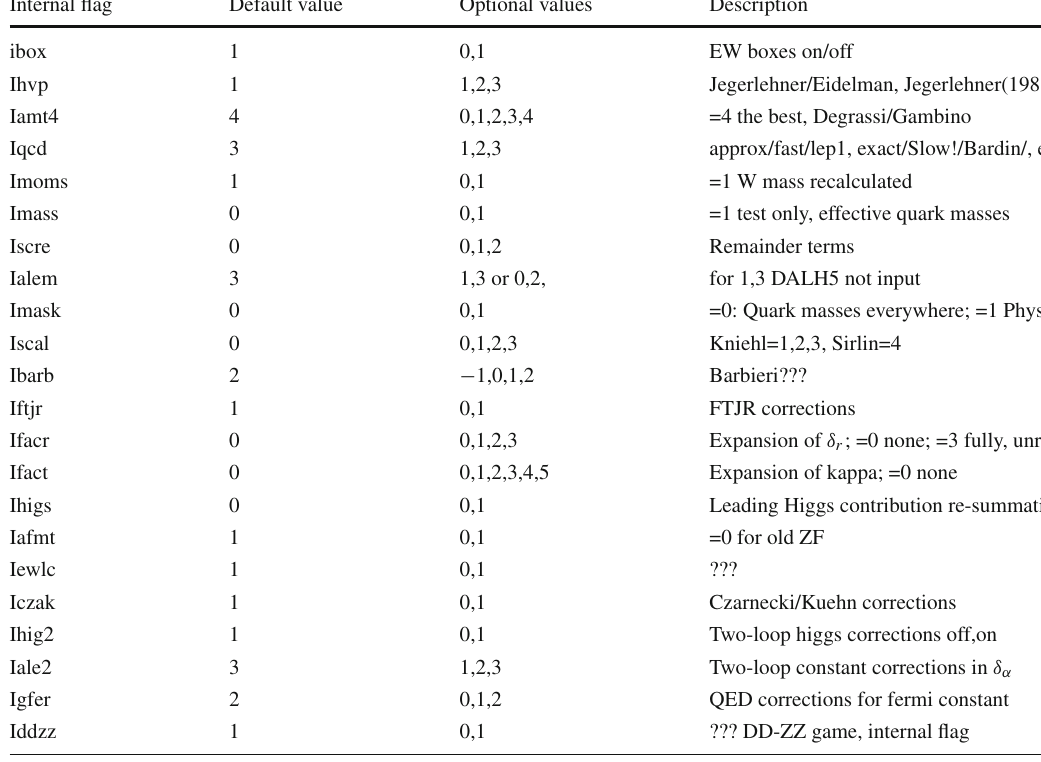
Table 12 Dizet recalculated quantities available for the TauSpinner use. For details of the ZPAR table see Refs.